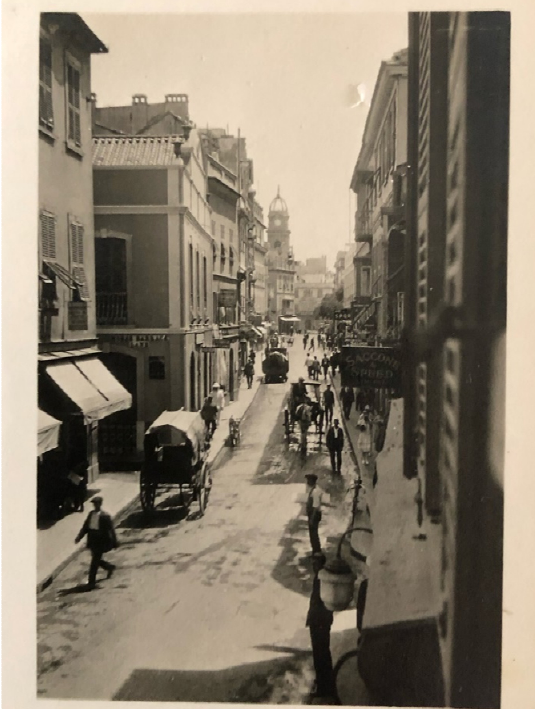
Figure 5. Early twentieth-century photograph of Main Street. To the left and before the horse carriage is 153 Main Street and the junction with Horse Barrack Lane. The cupola of the Cathedral of Saint Mary the Crowned can be seen in the distance.